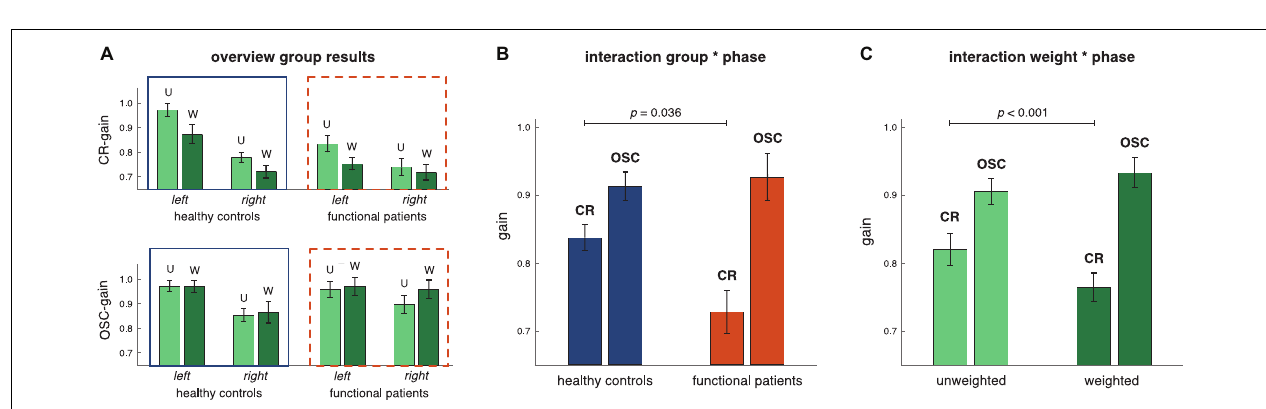
FIGURE 4 | Results of group analysis (controls n = 11, patients n = 8). (A) Shown are gaze gains (mean and SEM) for all factor steps of the rmANOVA, i.e., gains to the left vs. right side (within-factor side , left group vs. right group of bars), unweighted (U) vs. weighted (W, within-factor weight , left vs. right bar within each bar group), in the CR vs. OSC epoch (within-factor epoch , upper vs. lower bar plot) for the healthy controls as well as the functional patients (between-factor group , all bars within solid vs. dashed squares). (B) Shown are gaze gains (mean and SEM) for the group * epoch interaction. Gaze gains differed between healthy controls and functional patients [ F (1,17) = 14.63, p = 0.001, and partial η 2 = 0.463]: functional patients displayed smaller gaze gains in the CR ( p = 0.036) but not the OSC epoch ( p = 0.26). (C) Shown are gaze gains (mean and SEM) for the weight * epoch interaction. Gaze gains differed between the unweighted and weighted conditions [ F (1,17) = 20.24, p < 0.001; and partial η 2 = 0.54], being reduced with weight in the CR ( p < 0.001) but not the OSC epoch ( p =